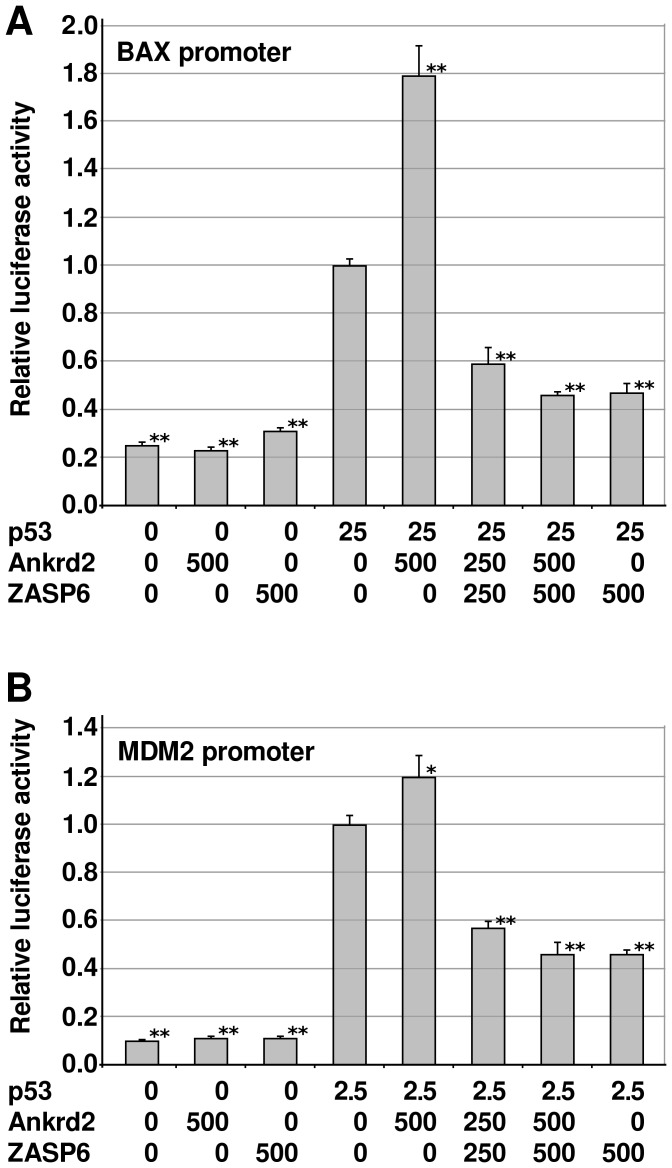
The effect of co-expression of ZASP6 and Ankrd2 on p53 transactivation of BAX and MDM2 promoters.Expression vectors for p53, ZASP6 and Ankrd2 were transiently transfected into SaOs2 cells along with a vector containing the Renilla luciferase reporter gene and (A) the BAX promoter-LUC or (B) the MDM2 promoter-LUC as indicated in the figure. The cells were lysed 16 h after transfection and luciferase activity was measured. Firefly luciferase activity was normalized to that of Renilla luciferase and presented as fold change relative to the activity when p53 alone was expressed. The plotted results were representative of three independent experiments performed in triplicate. Data were presented as means ± standard error of the mean. The Students t-test was done to determine the statistical significance, asterisks above the columns correspond to * p<0.05, **p<0.005.